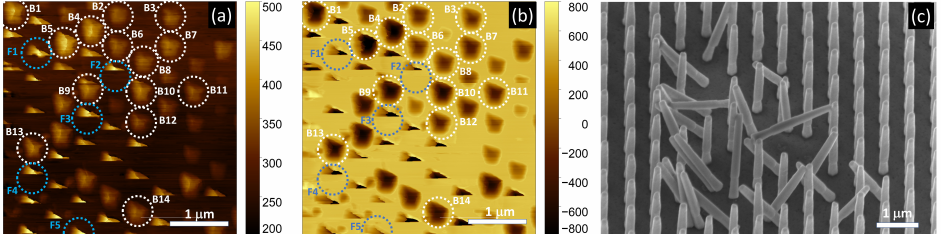
Figure 5. Lateral ( a ) and normal ( b ) PSPD signal maps taken upon the constant height scanning of the nanowires and tilt-view SEM image ( c ) taken on the same area after the scanning. Trapezoidal patterns in ( a , b ) show the sites where NWs remained unharmed (white circles), while triangles indicate fracture of the NWs (blue circles). Fourteen signal lines were selected to evaluate elastic NW bending (B1–B14) and five further ones to investigate the fracture (F1–F5).